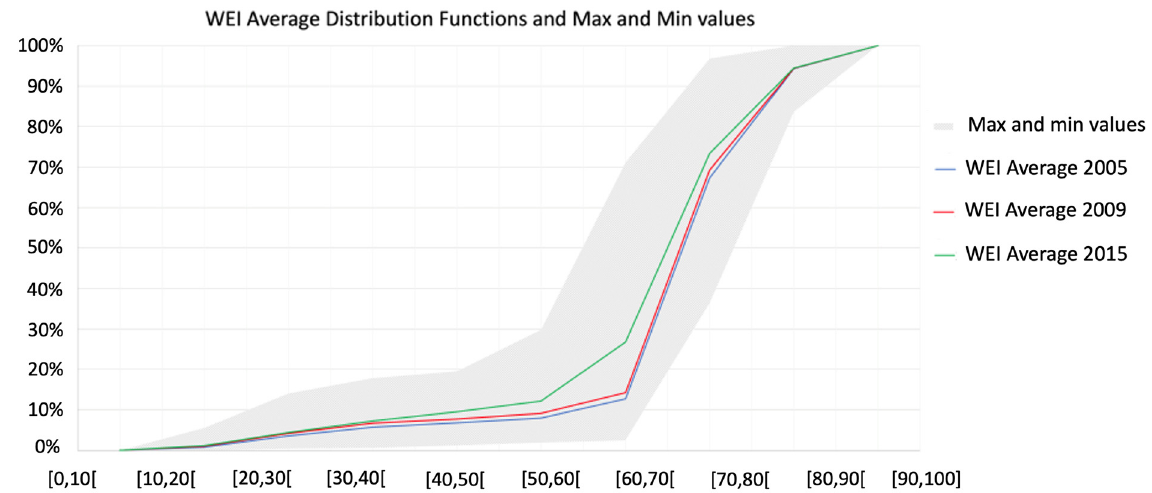
Figure 7. WEI average distribution function and maximum and minimum values.